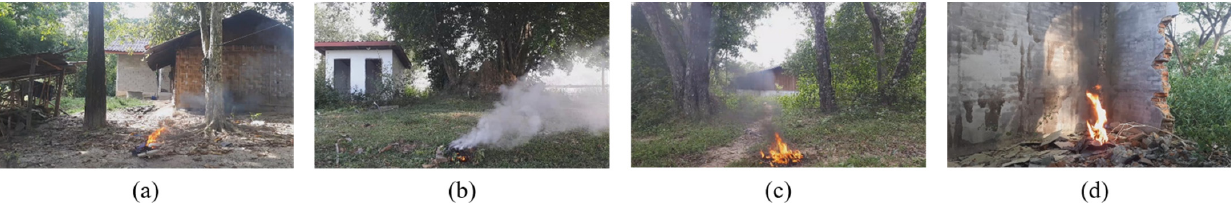
Figure 4. Fire prediction image data. ( a ) flames are visible ( b ) almost no flame ( c , d ) flame is detected by the eye.